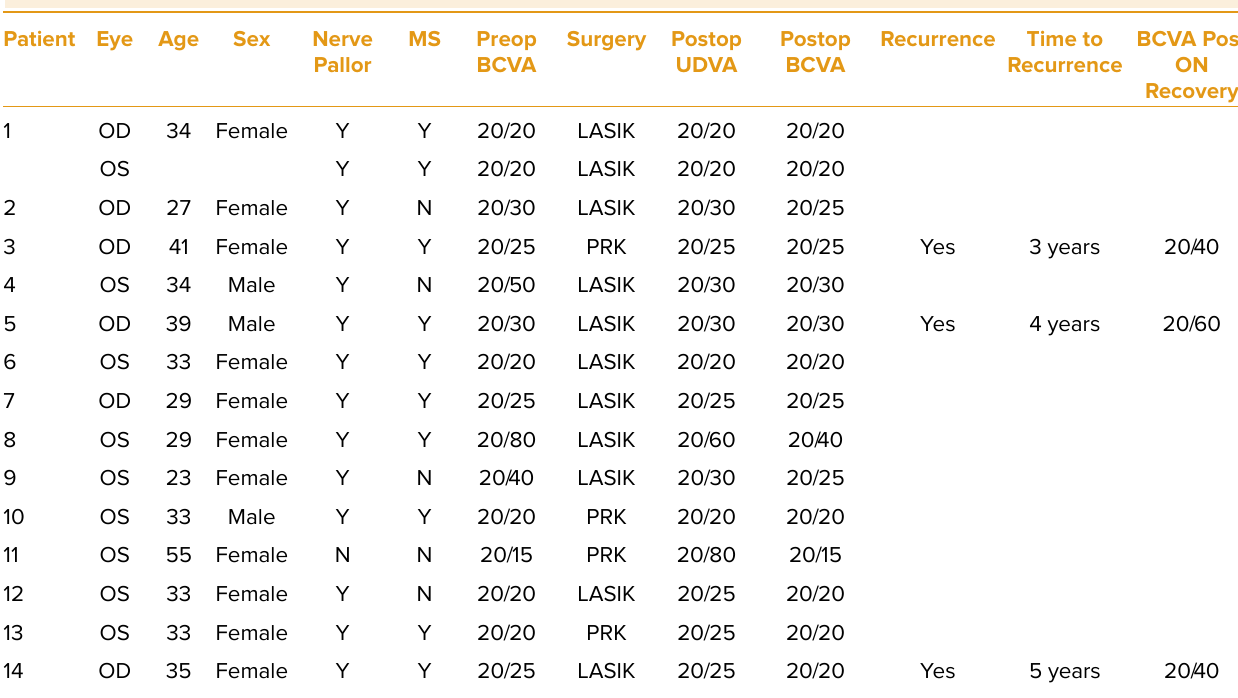
Table 1. Patients’ information.